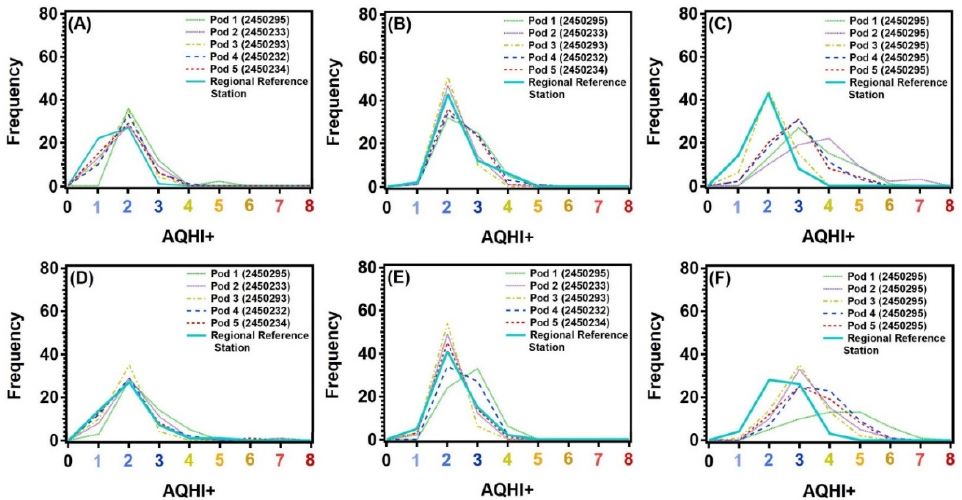
Figure 3. Histograms comparing the AQHI+ value frequency for each pod in the multisensor network in addition to the MECP reference station for drop off time intervals in ( A ) Fall 2020, ( B ) Winter 2021, and ( C ) Summer 2021, and for pickup time intervals in ( D ) Fall 2020, ( E ) Winter 2021, and ( F ) Summer 2021.